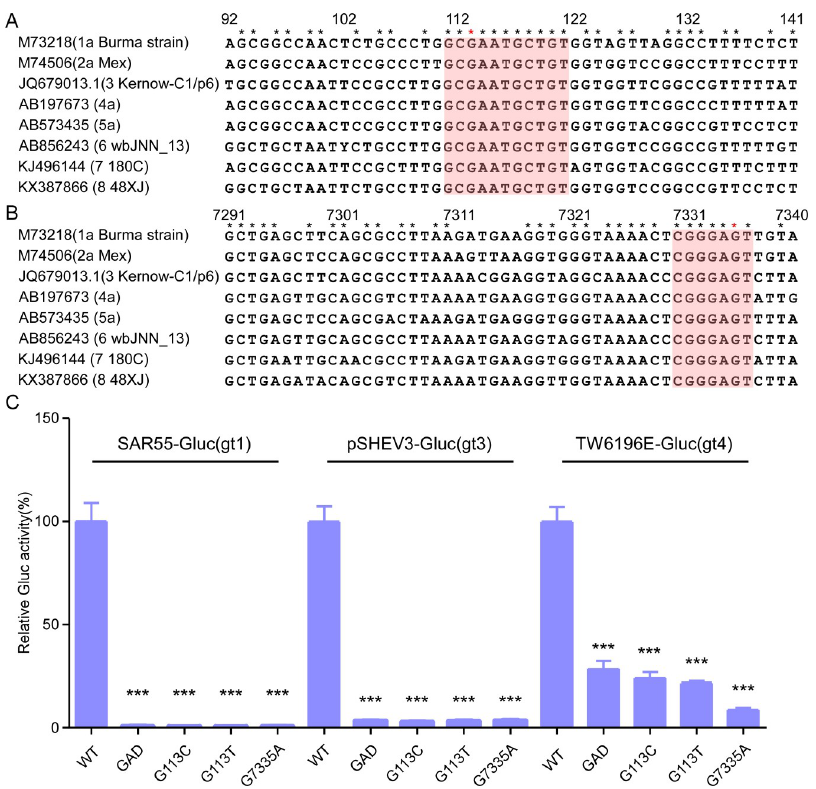
Fig 4. The cis -acting RNA elements are conserved and functional in multiple HEV genotypes. (A-B) Consensus sequences of the cis -acting RNA elements in ORF1 (A) and ORF2 (B) across genotypes 1 to 8 were aligned by MEGA6 software. The consensus sequences are shaded. G113 and G7335 are highlighted with a red star. (C) WT, synonymous mutant (G113C, G113T or G7335A) or GAD mutant RNA of SAR55 (gt1), pSHEV3 (gt3) or TW6196E (gt4) were transfected into HepG2C3A cells. Cell culture medium was collected two days after transfection, and Gaussia luciferase activity quantified. The data are presented as the percentage of Gaussia luciferase activity relative to that of the WT rHEV-Gluc. The numbering denotes the positions of the Kernow C1/p6 viral genome. Values are means plus SD (n = 4). ��� , P < 0.001 by one-way ANOVA.